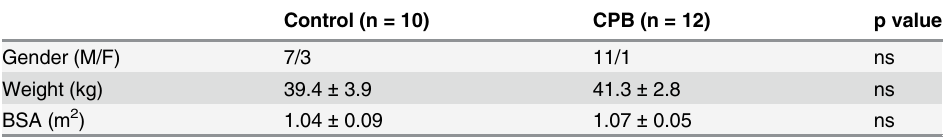
Table 1. Morphometric characteristics of the studied animals. Mean ± SD.